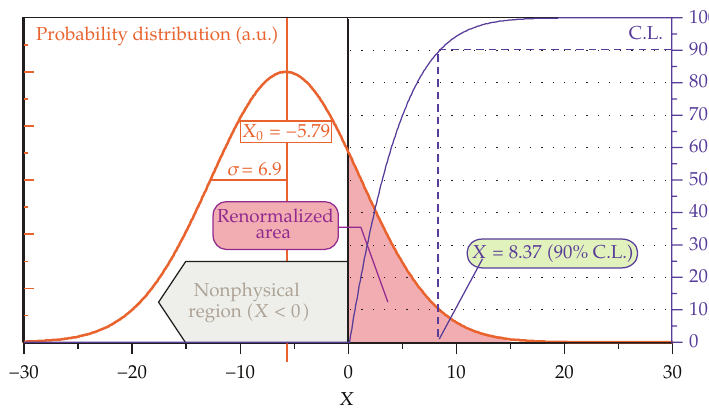
Figure 8: Final probability distribution of X .